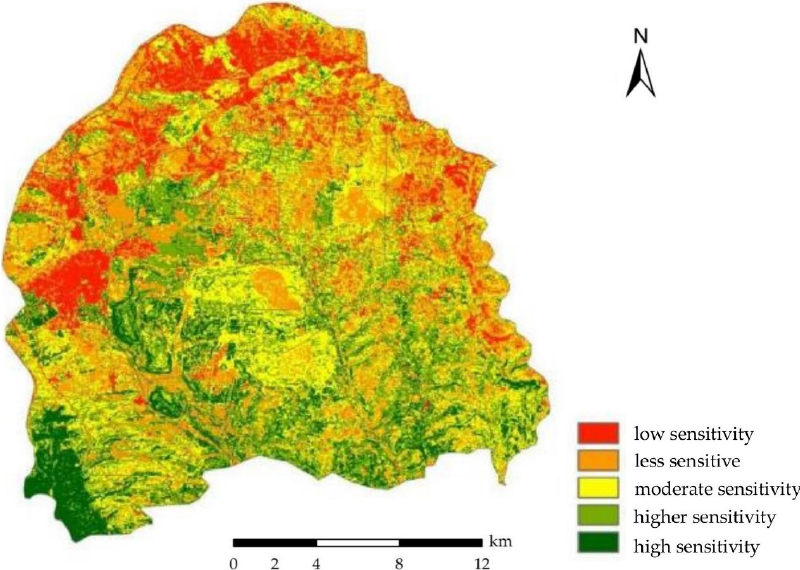
Figure 7. Distribution of ecological sensitivity in the mine–agriculture–urban compound